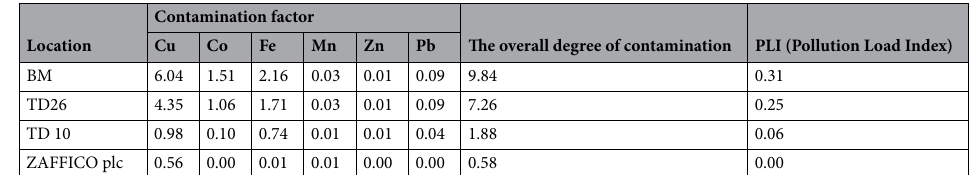
Table 3. Contamination factor, overall degree of contamination, and pollution load index of different heavy metals at BM, TD26, and TD10. The heavy metal concentration in ZAFFICO soil was used as a baseline to calculate the contamination